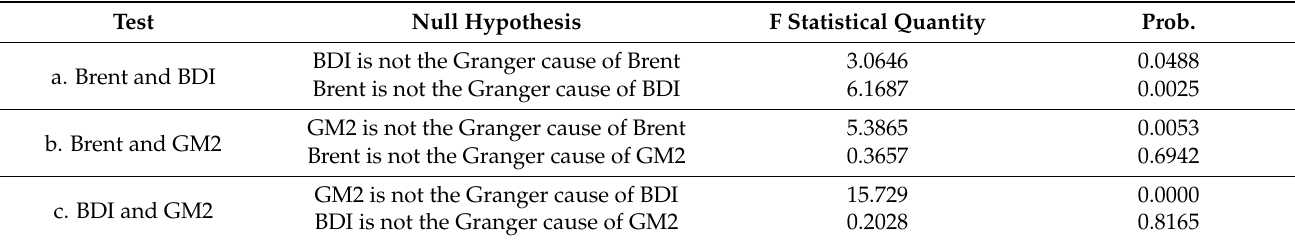
Table 2. Granger causality